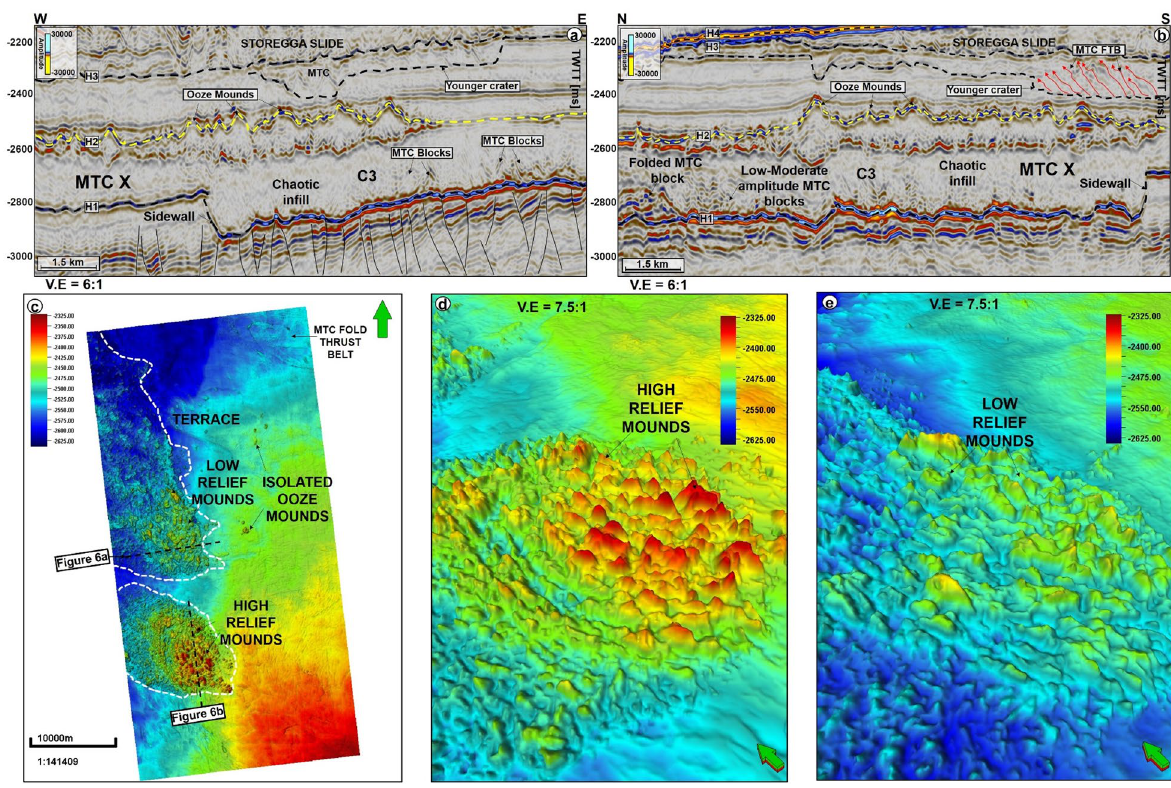
Figure 6. ( a , b ) Seismic profiles showing the distinct infill of C3 and the unusual presence of ooze mounds above this crater. Craters C3 and C4 in the Havsule area are distinctly underlain by polygonal faults and their tops reveal high to low relief ooze mounds. Where high relief ooze mounds are interpreted, the overburden is immediately characterized by younger craters. In addition to the chaotic infill of the craters, moderate to high amplitude slide blocks are also found within the craters. N.B: Uninterpreted seismic profiles are provided in the appendix. ( c ) Structural map of horizon H1 showing the ooze mounds distributed into two distinct domains. Isolated mounds are also found on the eastern part of MTC X. ( d , e ) 3D view of the two ooze-mound